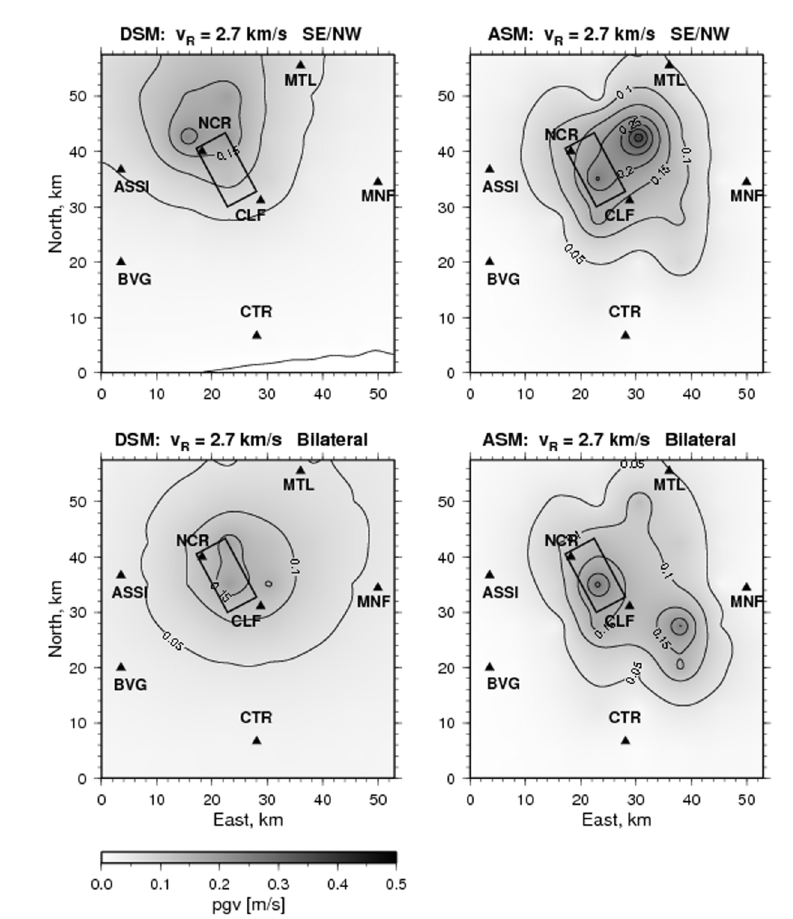
Fig. 5. Maps of mean synthetic PGV obtained for the Colfiorito earthquake using the DSM and the ASM sim- ulations. Top panels: unilateral SE/NW nucleation for a constant rupture velocity of 2.7 km/s; bottom panels: bi- lateral nucleation for a constant rupture velocity of 2.7 km/s. For all rupture models, the mean value of PGV is computed at each site from the distribution of peak values obtained from synthetics simulated by moving the nu- cleation point on the bottom half of the Colfiorito